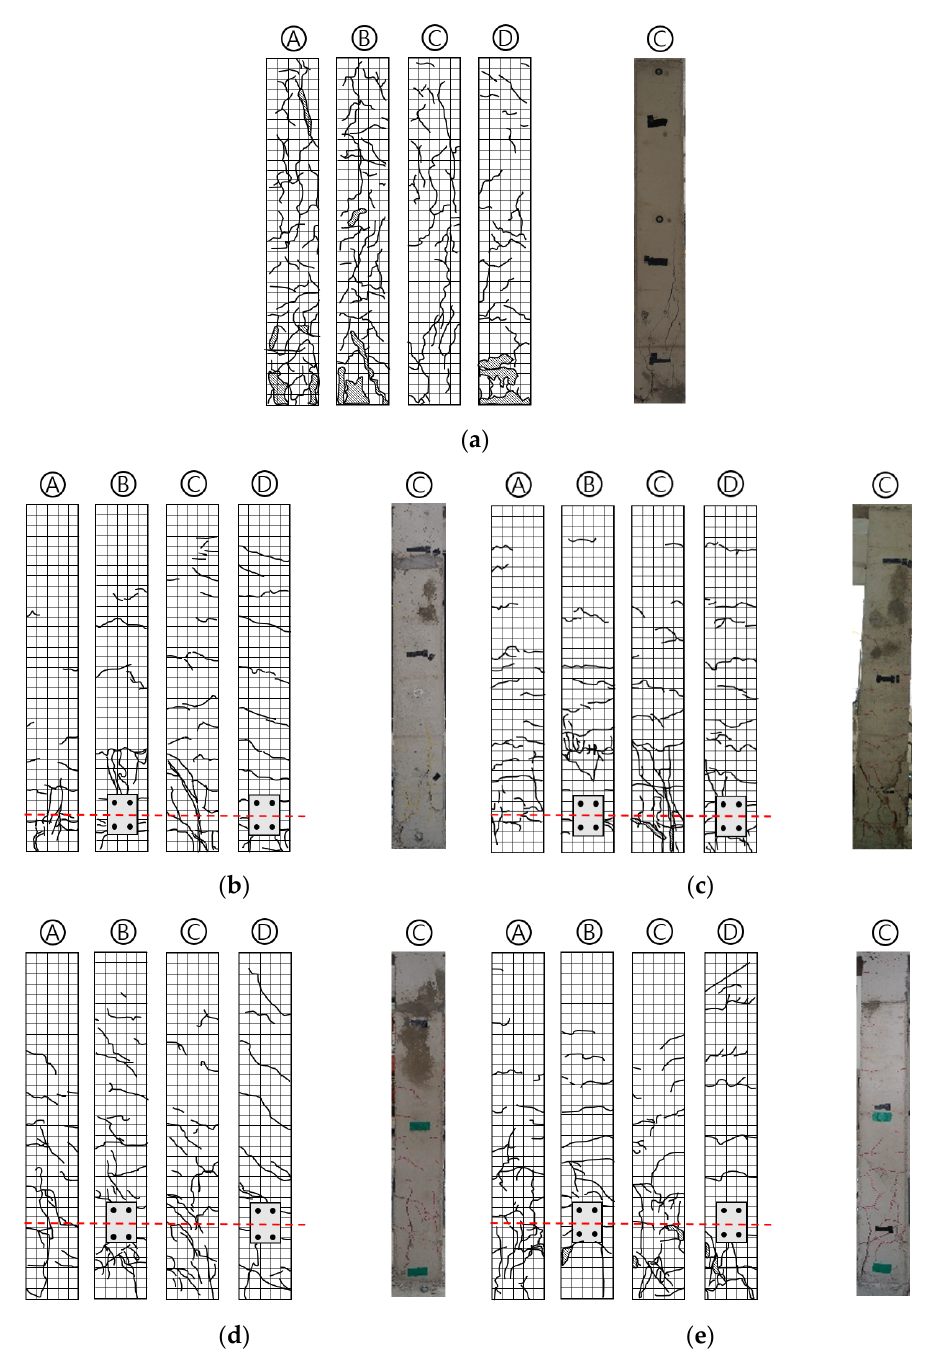
Figure 7. Crack patterns and failure of the specimens: ( a ) NR; ( b ) R-375-1; ( c ) R-375-2; ( d )R-575-1; ( e ) R-575-2.